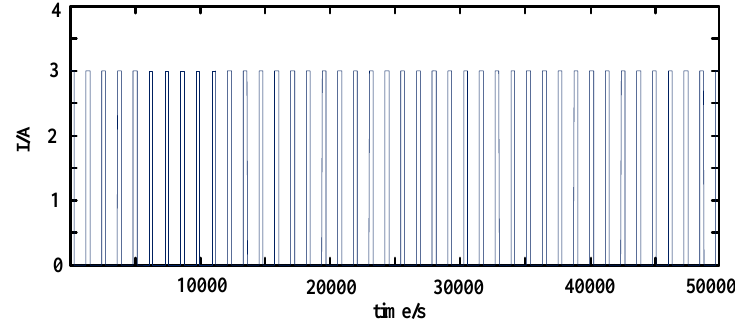
Figure 11. Discharge current curve.